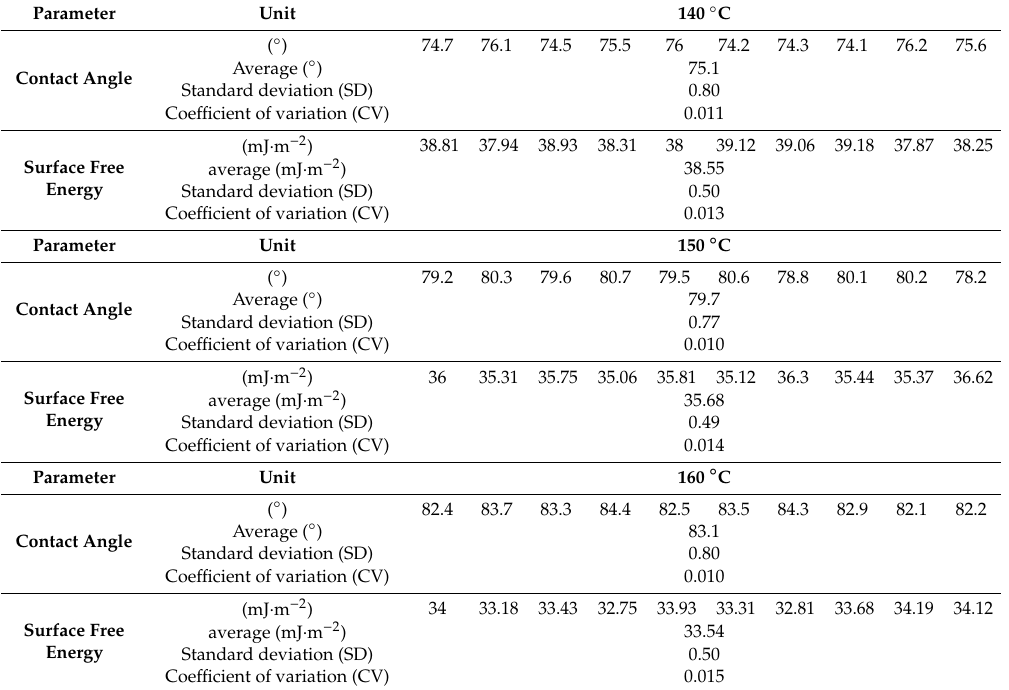
Figure 6. Contact angle of a water drop in mineral–asphalt mixtures: ( a ) WC-1; ( b ) WC-2. Table 6. CA and SFE values for the mineral–asphalt mixture WC-2.